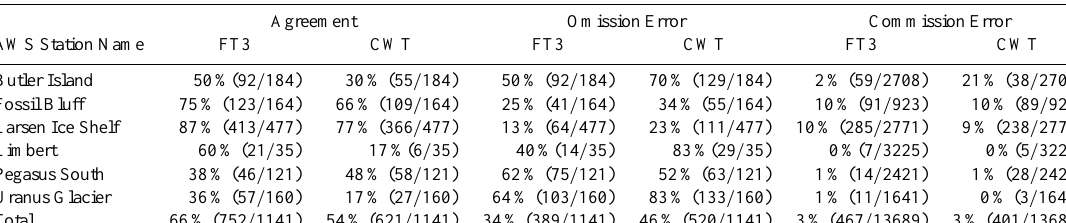
Table 1. Stations used in the AWS evaluation. Shown are the agreement (true positive), omission (false positive) and commission (true negative) relative differences from the comparison of melting estimated from AWS air temperatures and melt duration (MD) time series estimated using the FT3 and CWT melt algorithms.